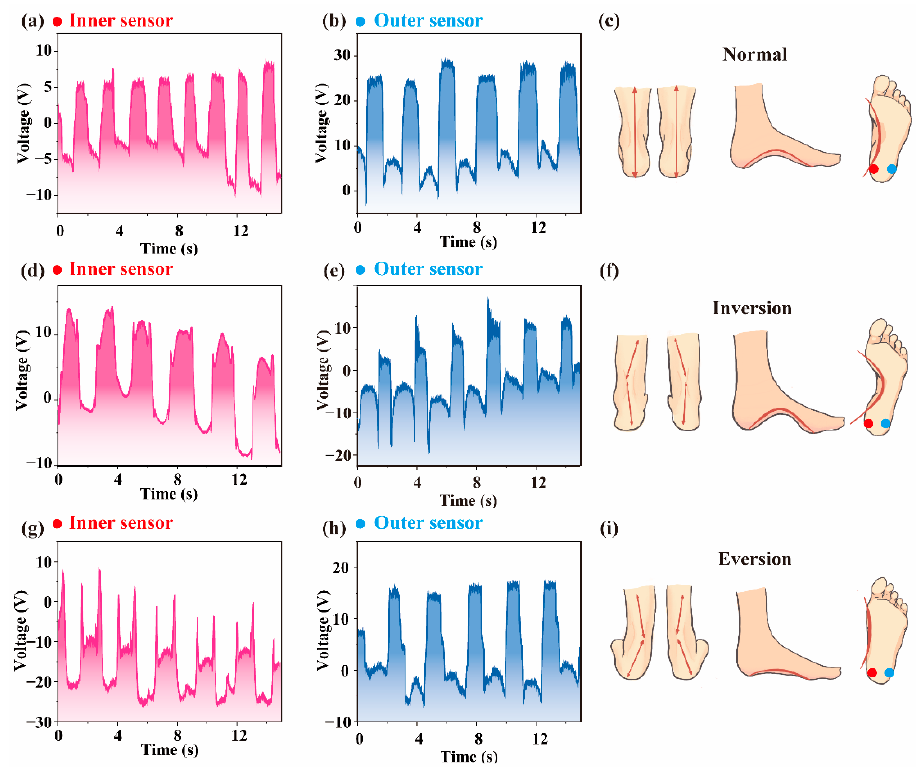
Figure 5. Voltage signals from the MXene-doped LLB TENGs for health monitoring of human feet: ( a – c ) normal, ( d – f ) inversion, and ( g – i ) eversion.